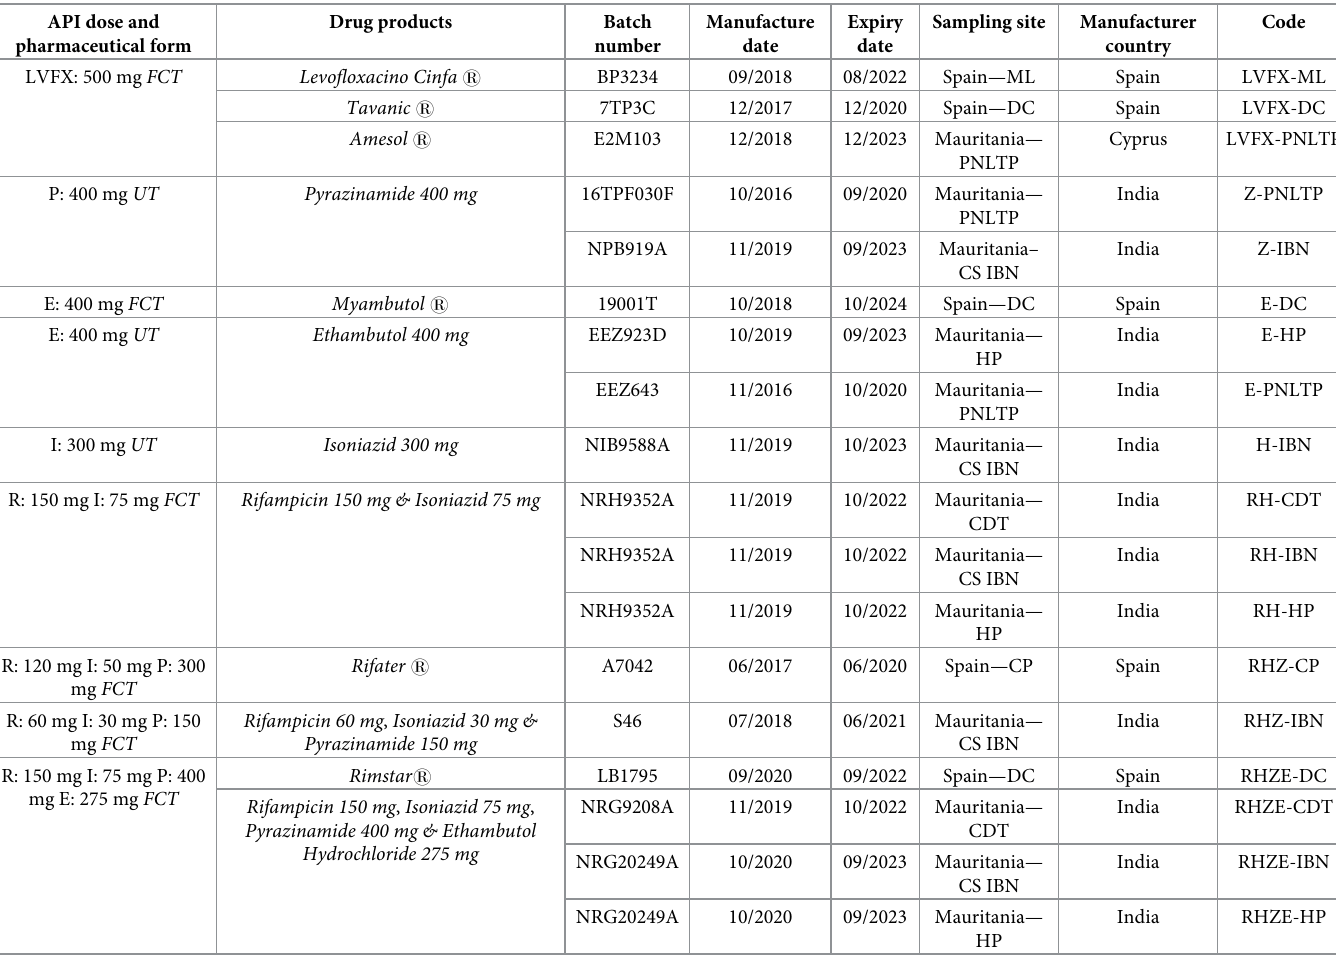
Table 3. List of antituberculosis drug products